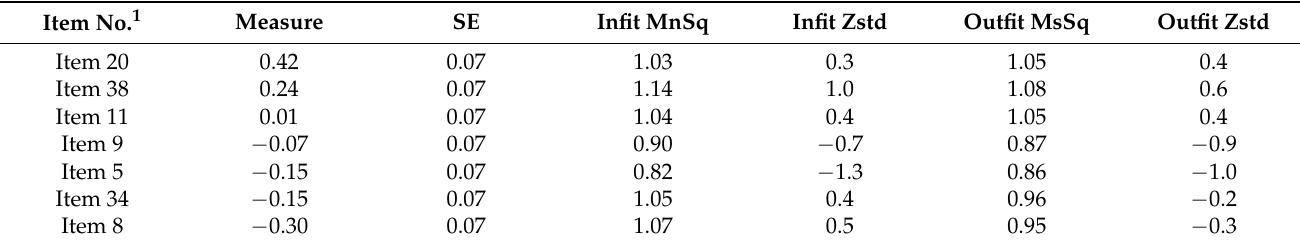
Table 2. Fit statistics in the seven-item Self-Reported Adherence to Patient-Centered Physical Therapy Scale.